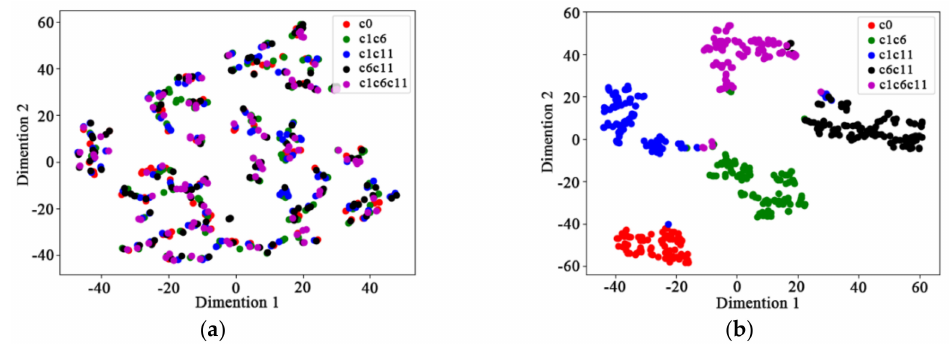
Figure 9. The two-dimensional display of data. ( a ) raw data ( b ) output data of